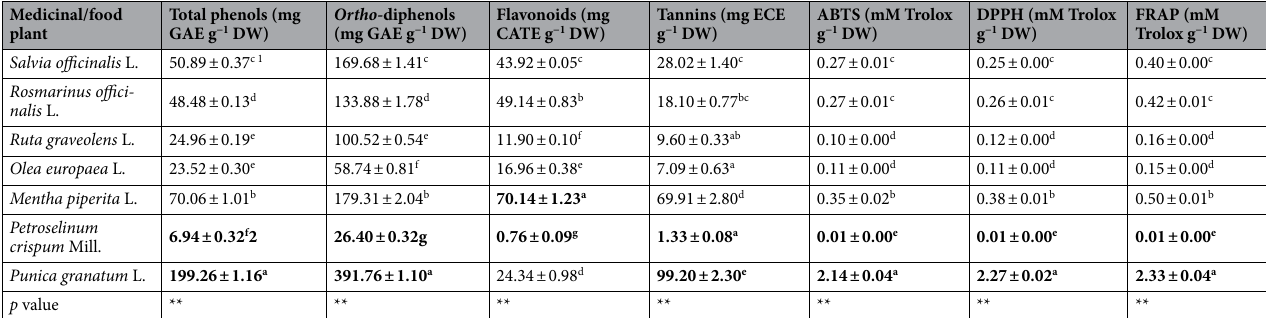
Table 1. Phenolic content and antioxidant activity of hydro-methanolic extracts of the studied medicinal and food plants. 1 Values are presented as mean ± SD (n = 3) for each phenolic group. Mean values followed by different superscript lowercase letters report significant differences between different plant extracts at ** p < 0.001, according to Tukey’ s multiple range test. 2 Values in bold represent the highest and the lowest for each parameter